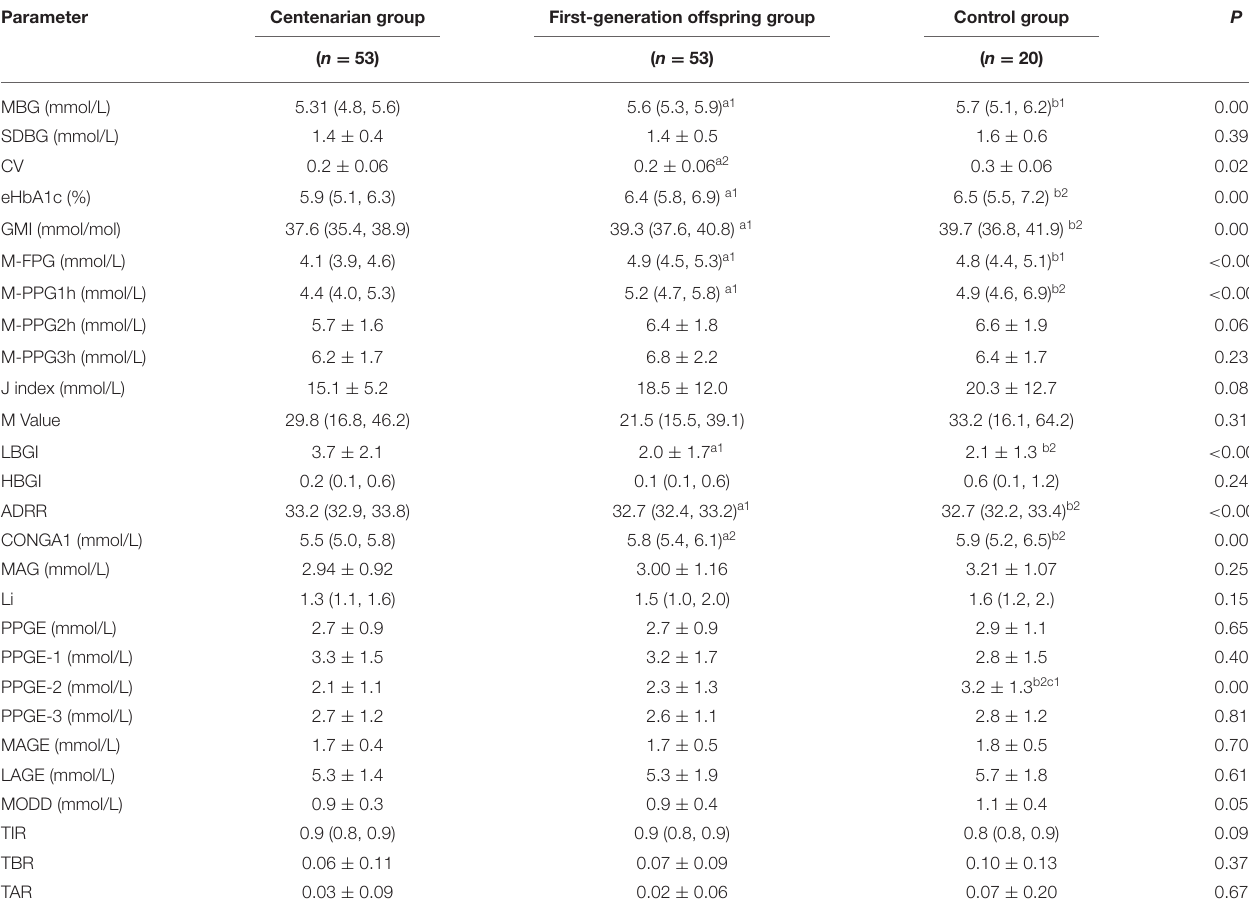
TABLE 2 | Continuous blood glucose parameters according to group assignment. Parameter Centenarian